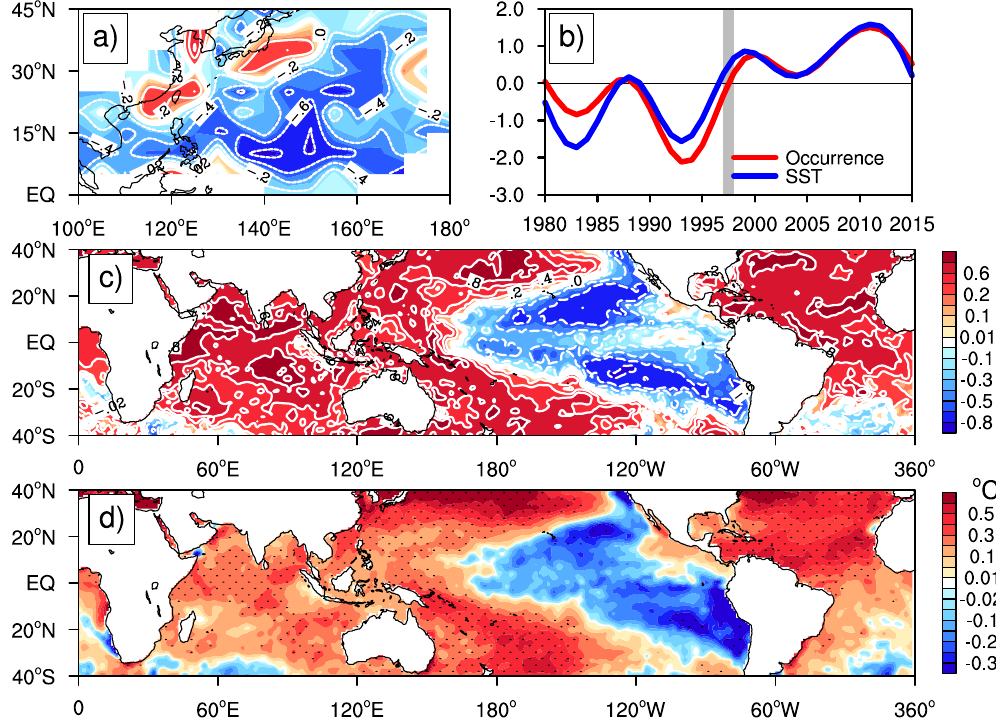
Figure 2. Spatial and temporal structures of the first SVD mode between ITCTs over the Northwest Pacific and global SST anomalies. ( a ) Singular eigenvector of the normalized ITCTs, ( c ) singular eigenvector of the normalized SST anomalies, ( b ) principal components (PCs) of the ITCTs and SST anomalies in non- dimensional units; and ( d ) composite differences in SST anomalies (°C) between the hiatus (1998 − 2015) and pre-hiatus (1980–1997) periods. The correlation coefficient between the two PCs in ( b ) is 0.91, which is significant at 99% confidence level based on the Student's t test after adjusting the effective degrees of freedom. Areas with the confidence level above 90% are shown by dots in ( d ). This figure was generated by the NCAR Command Language (Version 6.4.0) [Software]. (2017). Boulder, Colorado: